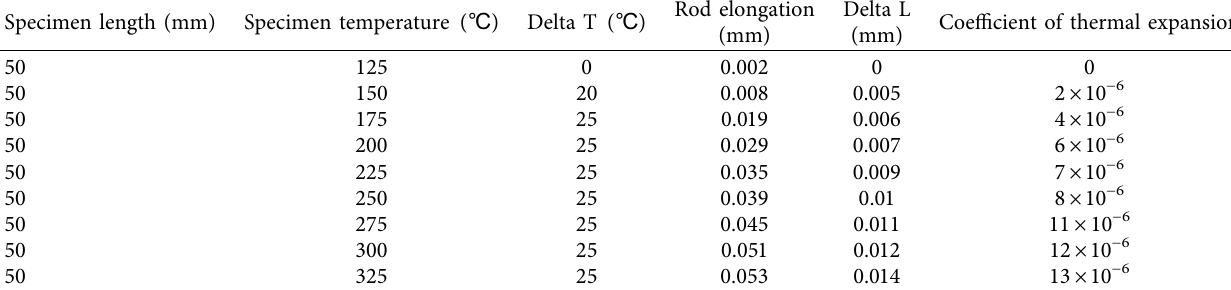
Table 12: CTE of the Ni-Cu alloy+ 9% TiO